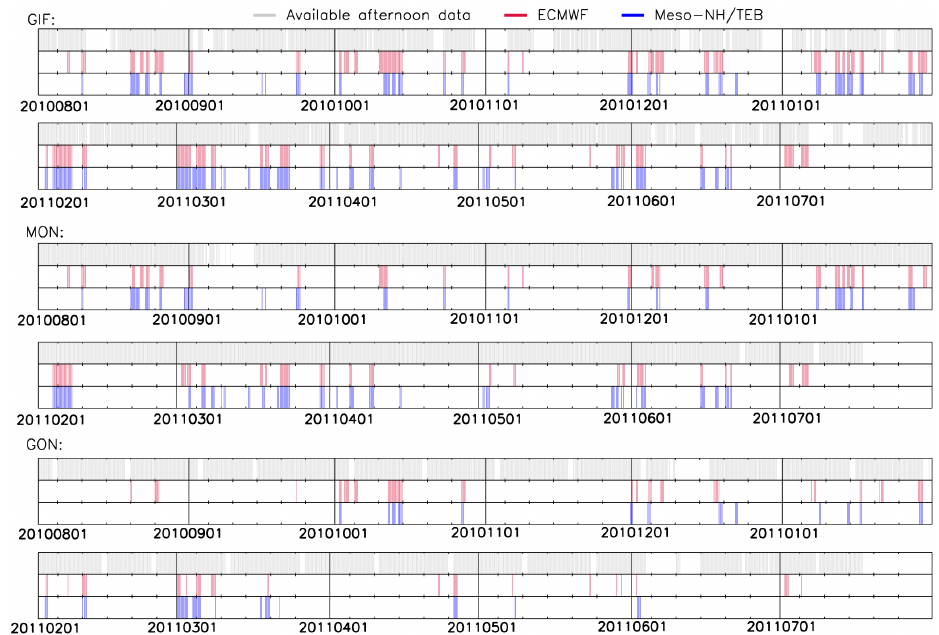
Figure 2. Afternoon (12:00–16:00) CO 2 data availability during the CO 2 -MEGAPARIS project (August 2010–July 2011) for the different monitoring sites used in this study. Grey vertical lines: available hourly observed data. Red and blue lines: observations that are actually assimilated when using the reference (stringent) gradient selection criteria. Selection when using ECMWF (red lines) and Meso-NH/TEB (blue lines) wind fields for the wind